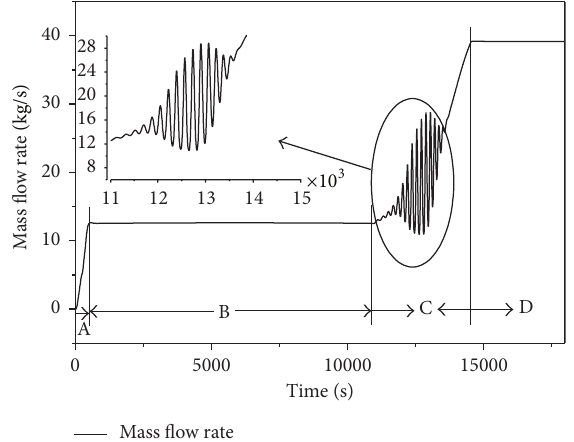
Figure 3: Mass flow rate evolution after OLPCCS being activated.